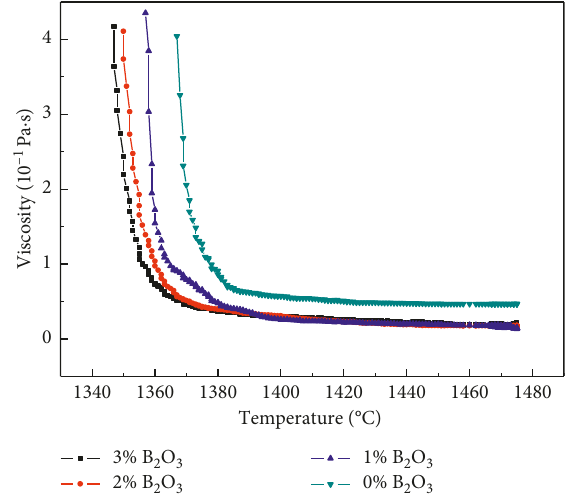
Figure 2: The relationship between apparent viscosity and the amount of B 2 O 3